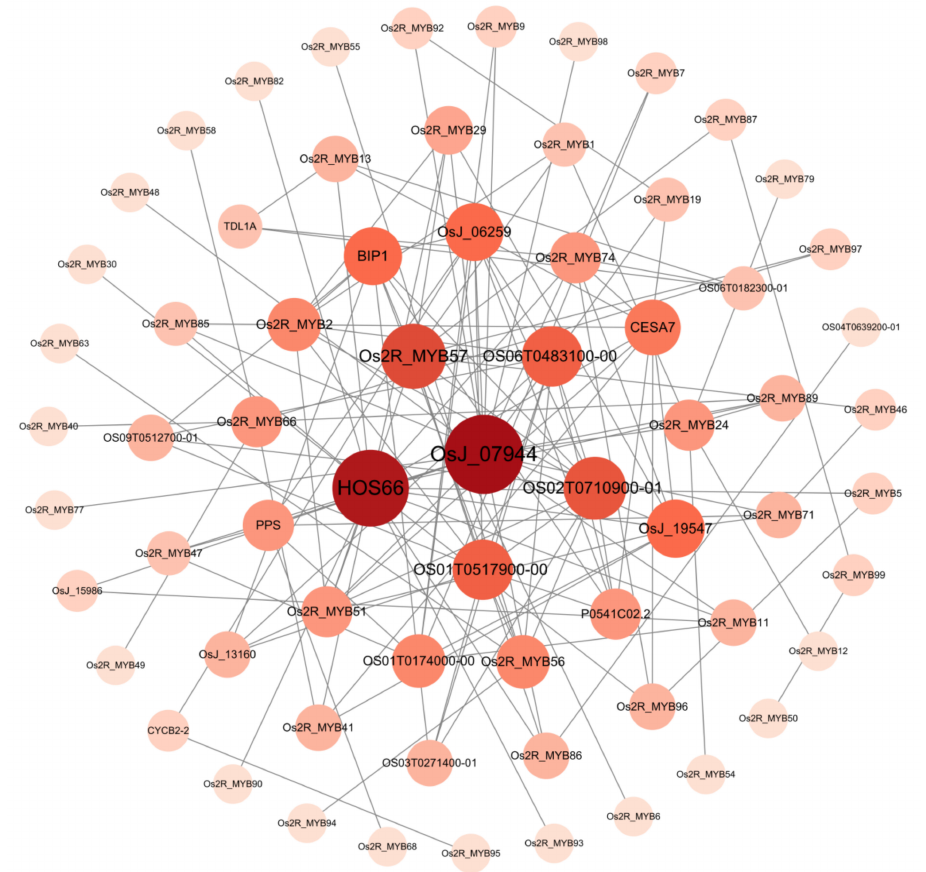
Figure 8. Interaction analysis of R2R3_MYB proteins using the STRING servers in rice. The nodes represent different proteins, and the edges represent the interaction between proteins. Proteins are arranged according to the degree (degree = 1–18) algorithm in Cytoscape. The value of degree corresponds to the color shade and size of